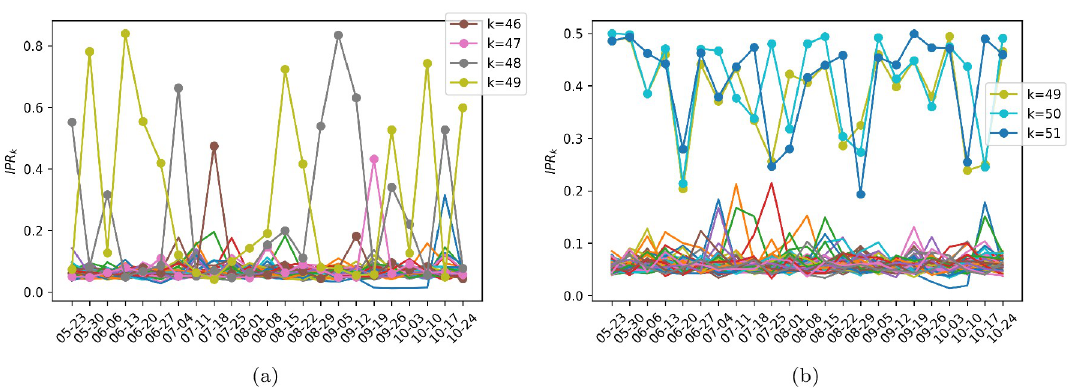
Fig 10. IPR as a function of time. Dynamic inverse participation ratio for the set of subsample data matrices described above. The regularization parameter and level of significance are set to λ = 0.01 and α = 0.01, respectively. (a) Predictor factors. (b) Response